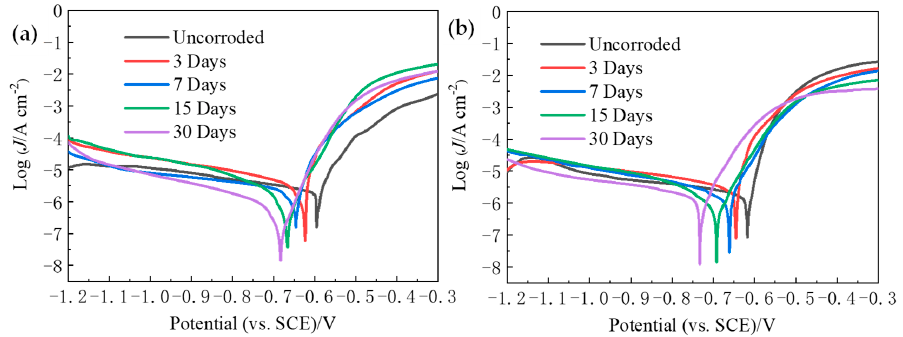
Figure 8. Polarization curves of the 5083/6005a welded joints after corrosion by the 3.5% + 0.01 mol/L NaHSO 3 solution: ( a ) 5083 aluminum alloy matrix; ( b ) 6005A aluminum alloy Table 3. Test results of polarization curves in different environments for the 5083/6005A welded joints.